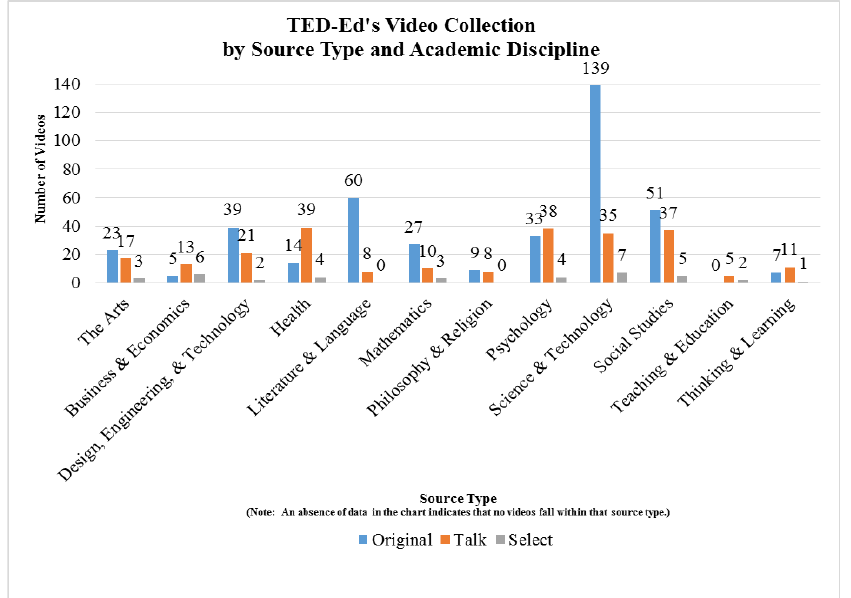
Figure 6. The total video distribution by source type and academic